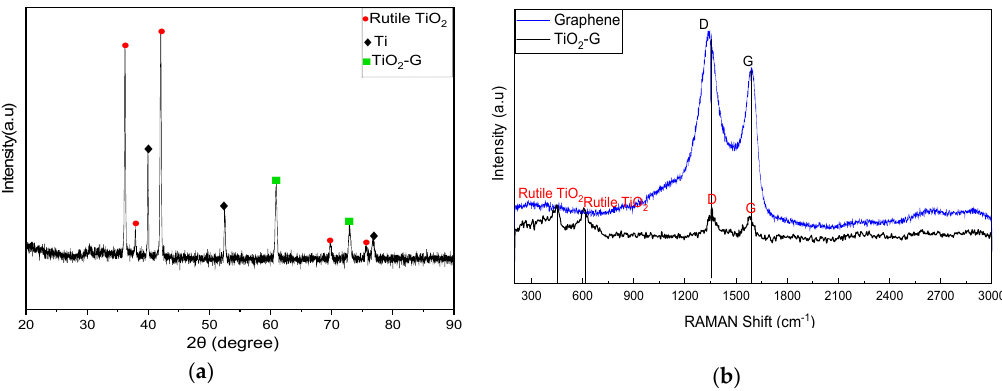
Figure 2. ( a ) The X-ray di ff raction spectroscopy pattern of TiO 2 -G film. ( b ) Raman spectra recorded for the electrode TiO 2 -G film and pristine graphene.